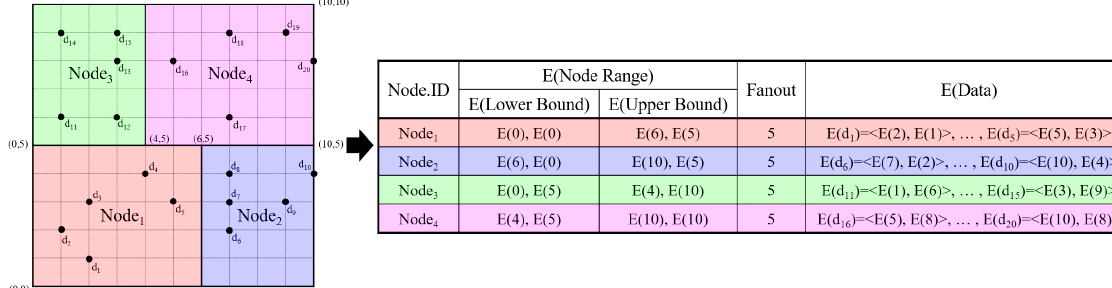
Figure 2. Example of the encrypted k